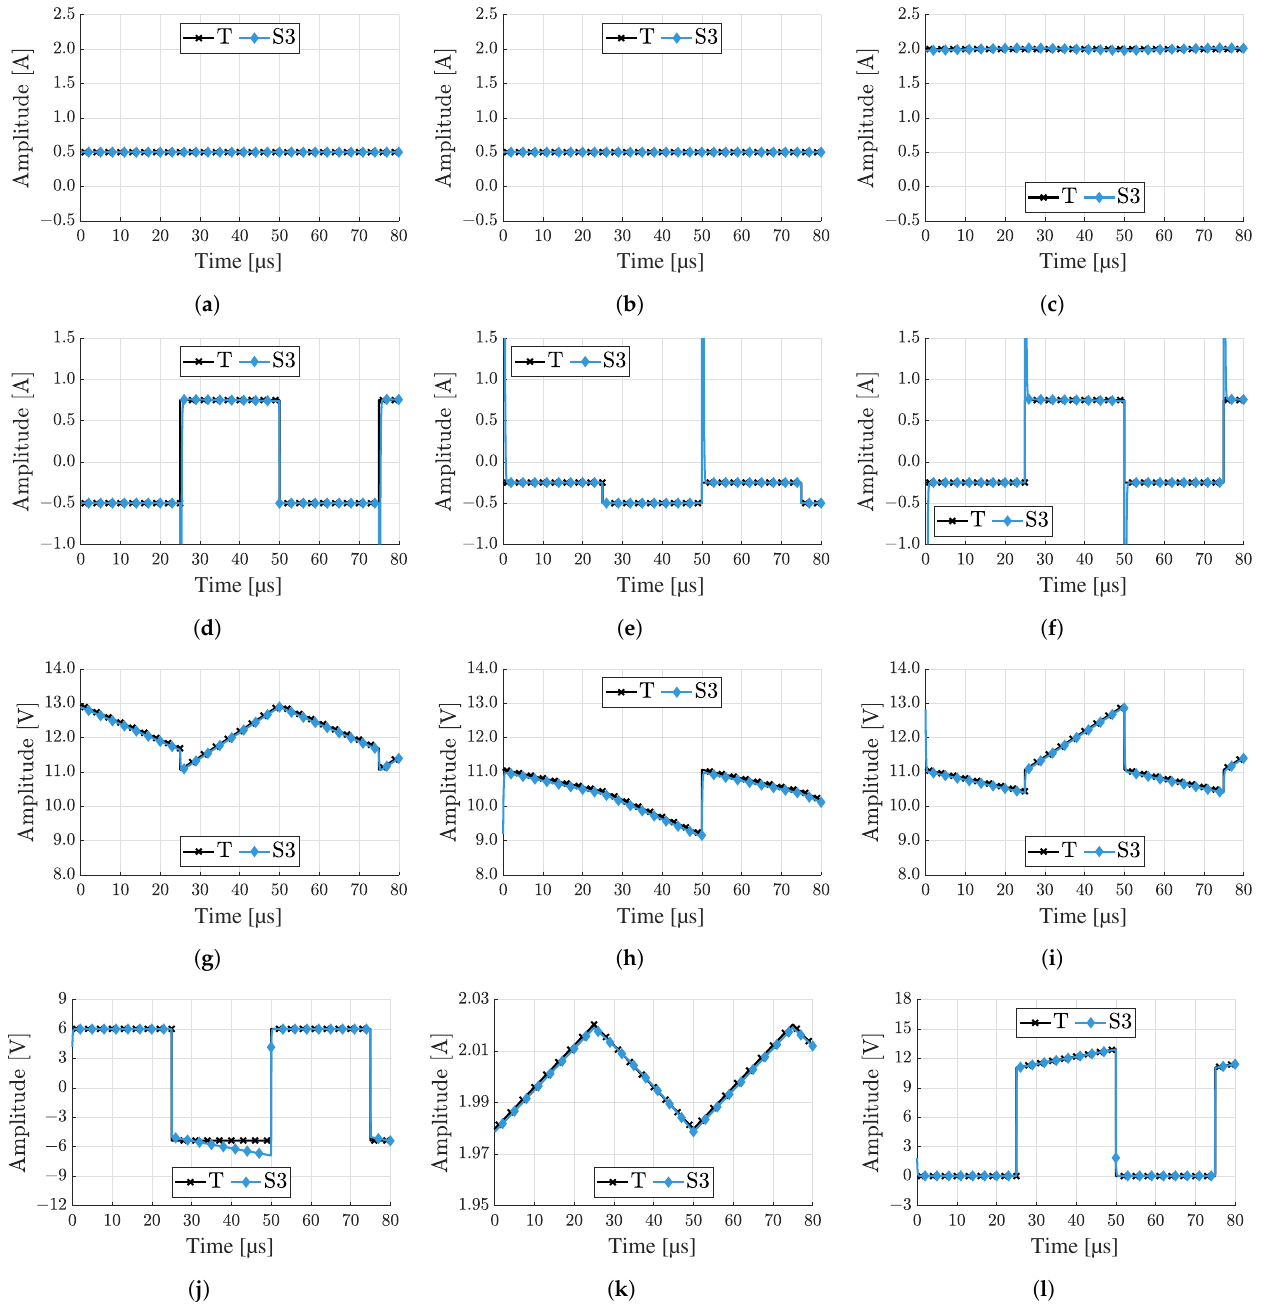
( t ) with small ripple approximation. B